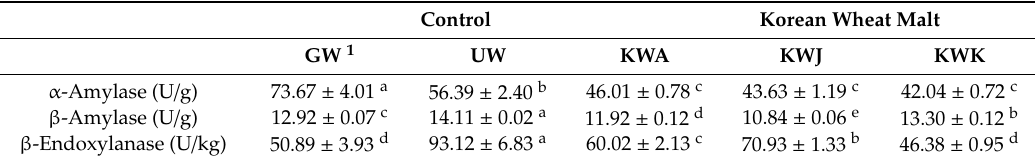
Table 3. Enzyme activities of wheat malts.